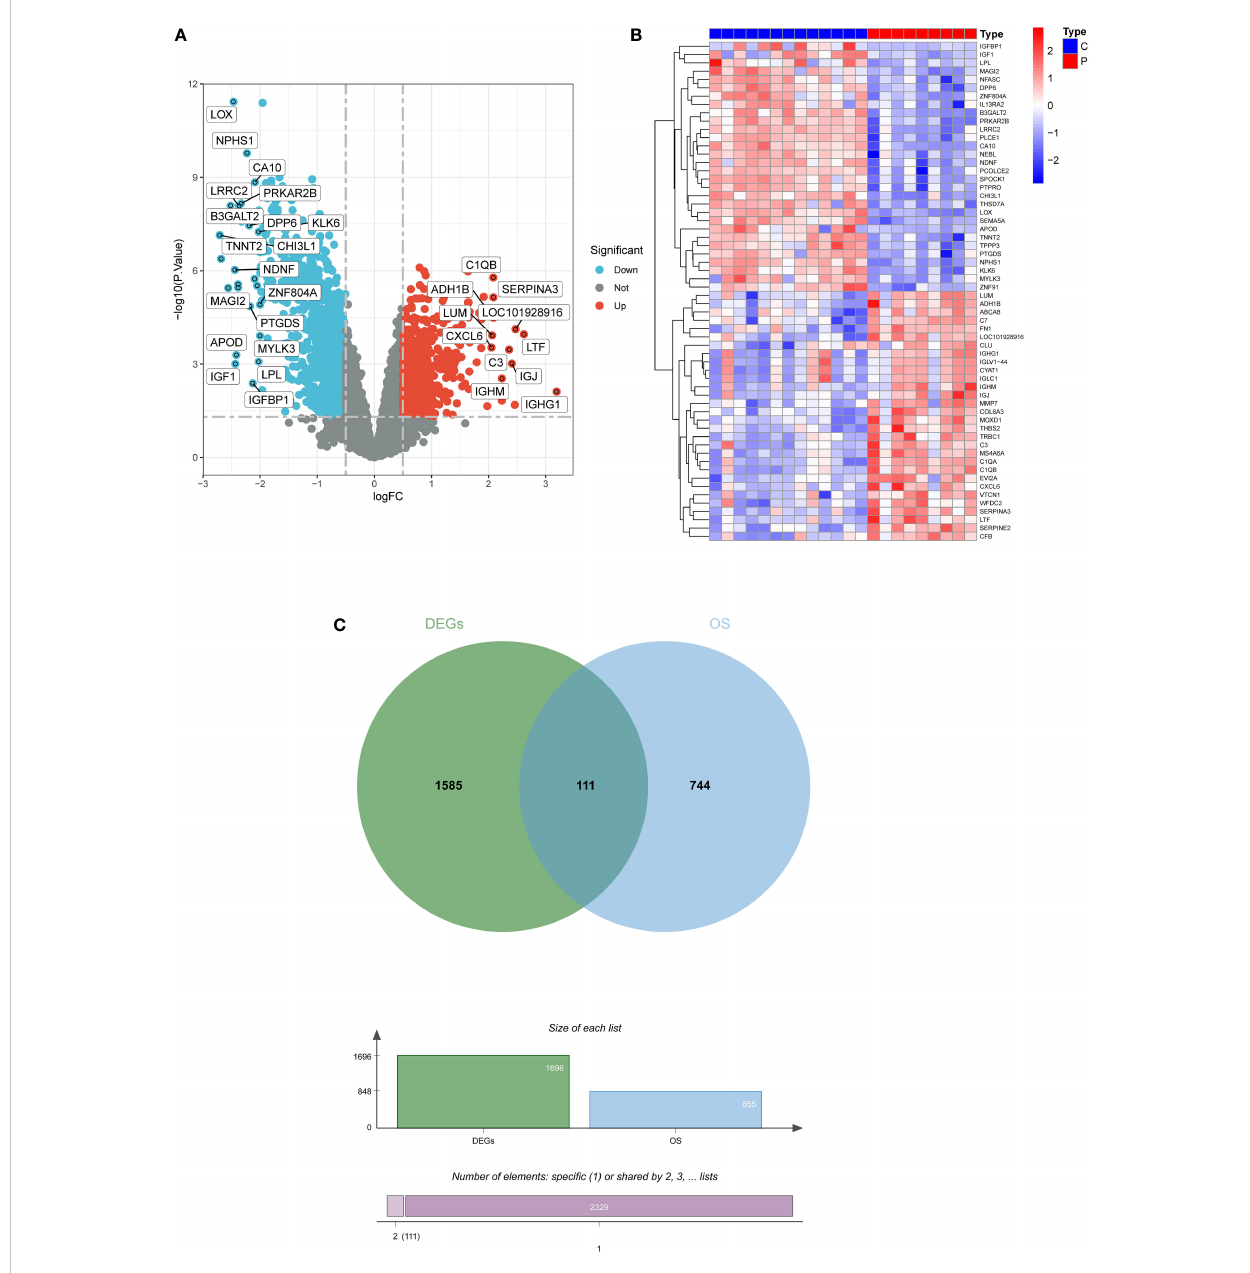
FIGURE 2 Screening for DEGs. (A) Volcano plot of DEGs in GSE30528. (B) Heatmap of DEGs in GSE30528. (C) Venn diagrams of DEOSGs. DEGs, differentially expressed genes; DEOSGs, differentially expressed genes related to oxidative